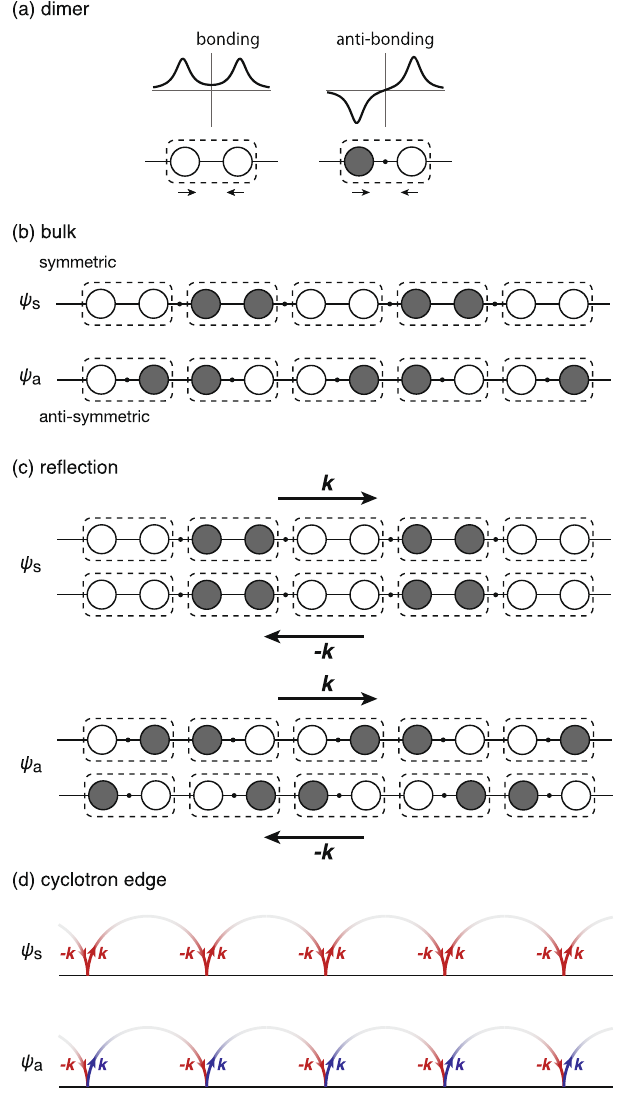
Fig. 8 Wave functions of electrons with the Peierls distortion. a The wave function in the unit cell (dimer) can be expressed in terms of bonding and anti-bonding molecular orbits. The white and black circles express the sign of the wave functions. The dots express the positions of nodes in the wave function. b The symmetric ( ψ s ) and antisymmetric ( ψ a ) wave functions can be expressed in terms of bonding and anti-bonding as well. c The sign of ψ a is inverted by the parity operation ( k → − k ), while that of ψ s is unchanged. It is thus naively expected that ψ a is strongly disturbed around the boundary by the normal re fl ection. d Illustration of the parity operation in the cyclotron edge. In the antisymmetric case, there is a π phase shift between incoming and re fl ected cyclotron orbits interrupted by the